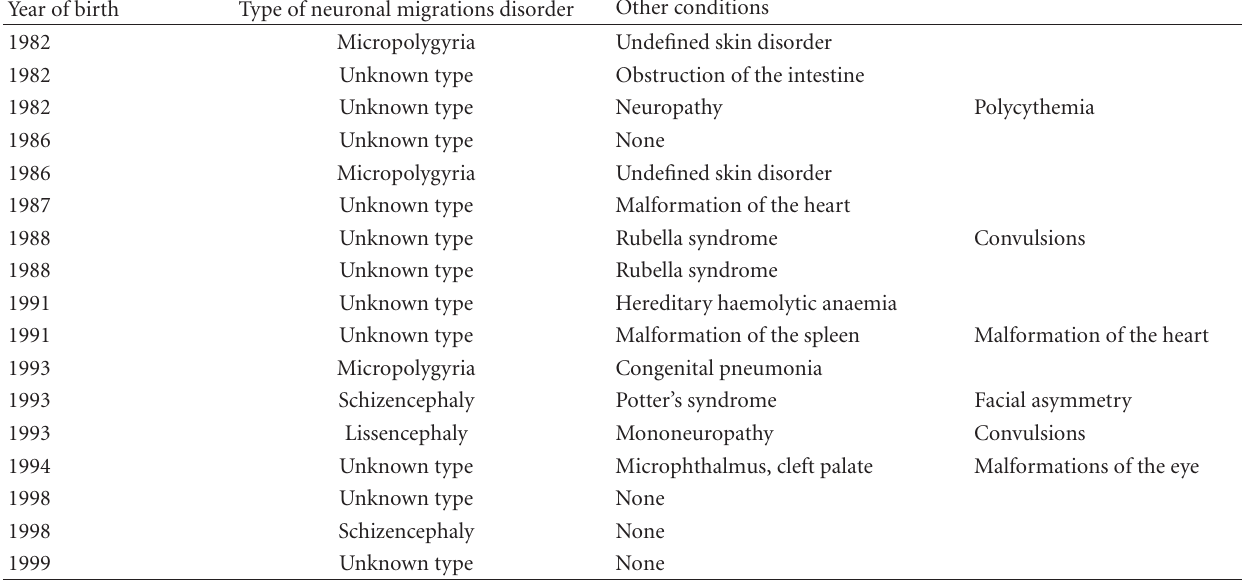
Table 2: Infant conditions: year of birth, type of migration disorder, and concomitant